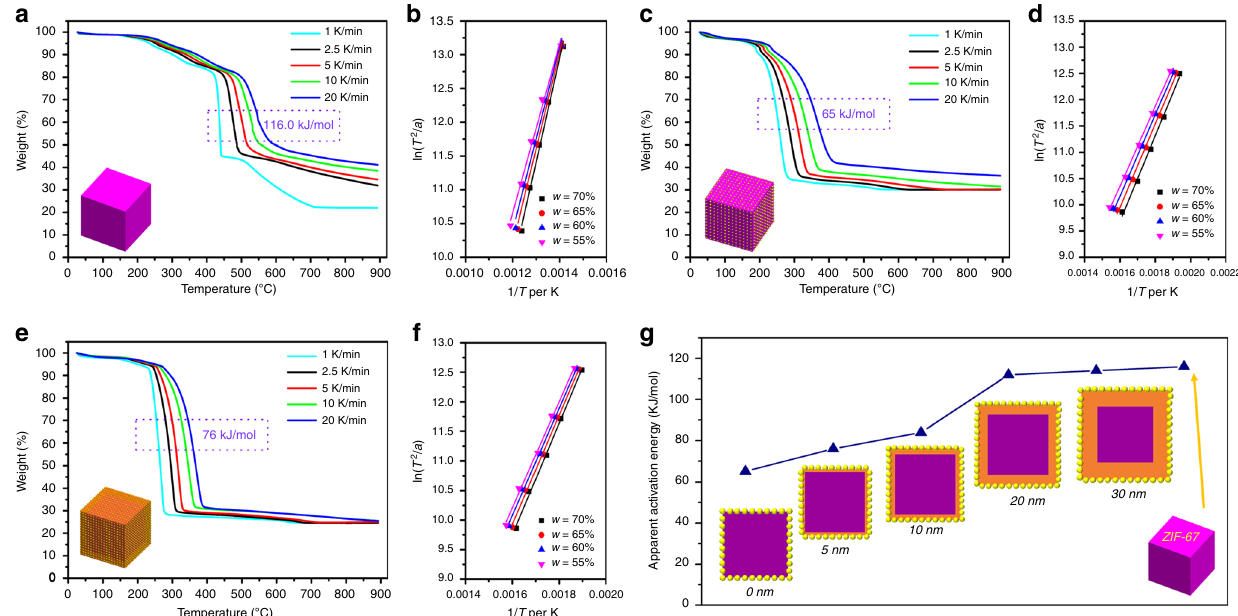
Fig. 8 Comparison of the apparent activation energy ( E a ) for ZIF-67 hydrogenolysis. a , c , e TGA curves of ZIF-67, ZIF-67/Pt and ZIF-67@ZIF-8/Pt at varying heating rates (1, 2.5, 5, 10 and 20 K min − 1 ) in H 2 fl ow (100 mL min − 1 , H 2 % = 4.2% in N 2 ), b , d , f the corresponding plots of ln( T 2 / ϕ ) versus 1/ T for the for indicated fractional weight ( w ) of ZIF-67 decomposition, and g the comparison of E a for ZIF-67 hydrogenolysis in ZIF-67@ZIF-8/Pt with different ZIF-8 layer thickness. The structural con fi guration of ZIF-67/Pt is shown in Fig. 5a, b, and the structural con fi gurations of ZIF-67@ZIF-8 with different shell thickness are depicted in Supplementary Fig.